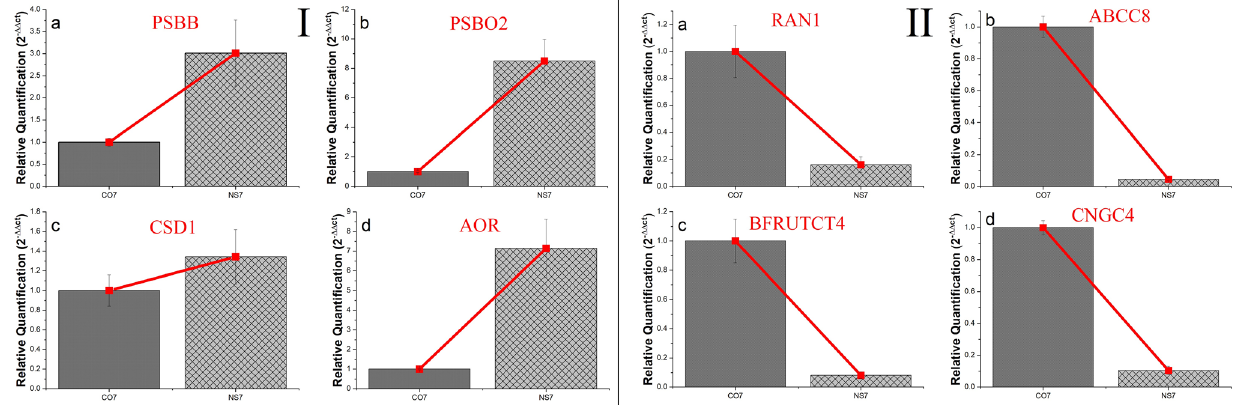
Figure 19. Validation of key differentially expressed up-regulated ( I ) and down-regulated ( II ) genes using qRT- PCR analysis. The y-axis indicates relative quantification of the genes and the studied genes were indicated in the x-axis. Error bar indicates the value of standard deviation (±